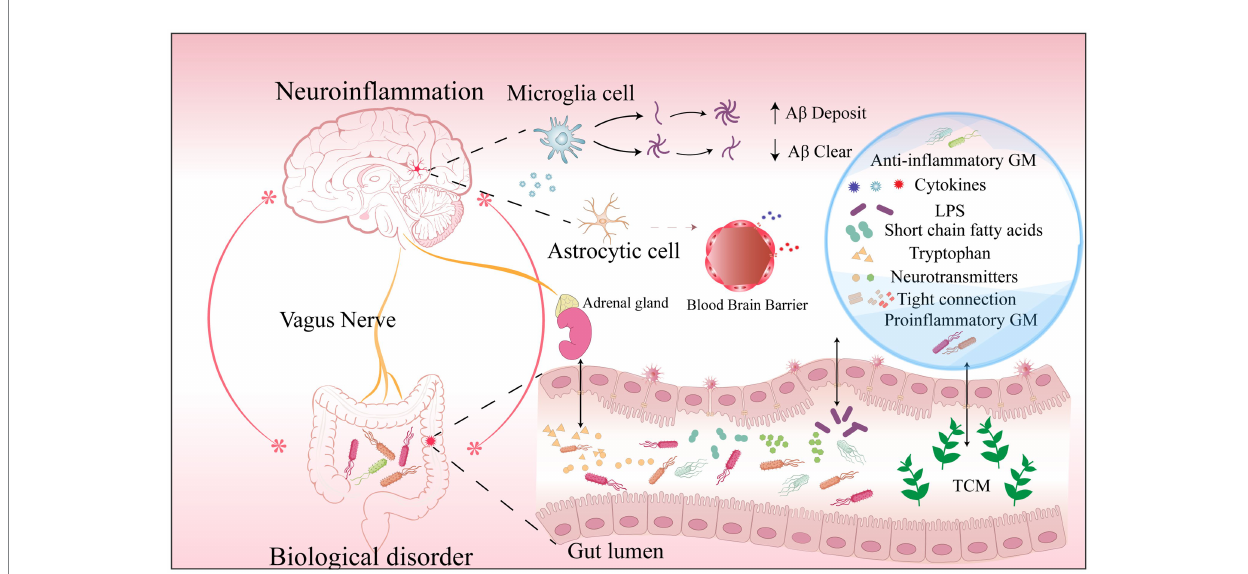
FIGURE 2 Biomarkers in the AD microbiome-gut-brain axis.Dysbiosis results in (1) a decrease in specific beneficial microbiome and metabolites and an increase in pro-inflammatory microbiome and harmful metabolites; (2) Increased intestinal permeability markers in serum and feces due to disruption of tight junctions; (3) Increased release of cytosolic inflammatory factors from microglia; (4) An increase or decrease in specific neurotransmitters involved in the development of AD. They are potential gut biomarkers in AD. Traditional Chinese Medicine ingredients can reduce AD pathology and improve cognitive function in a multi-targeted and multi-pathway manner by modulating intestinal microbes and metabolites, reshaping the intestinal barrier, and reducing neuroinflammation. Abbreviations: AD: Alzheimer’s disease; GM: gut microbiome; LPS: lipopolysaccharide; A β : amyloid- β protein; TCM: traditional